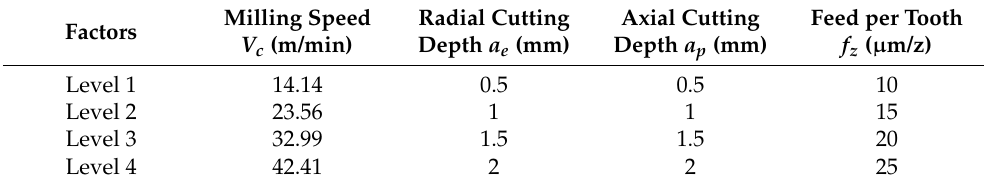
Table 3. The level variations of milling processing